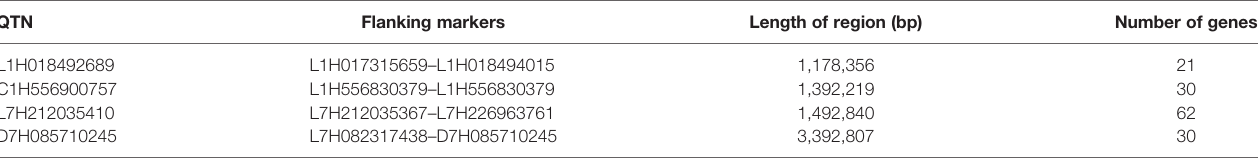
TABLE 5 | Quantitative trait nucleotides present at both locations, estimated fl anking region, and gene numbers. QTN Flanking